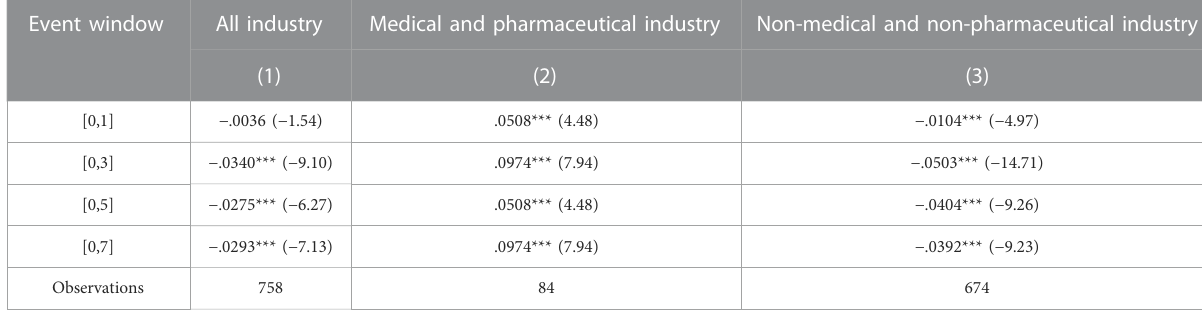
TABLE 2 The GEM ’ s respond to “ Bad News ” (lockdown of Wuhan City).